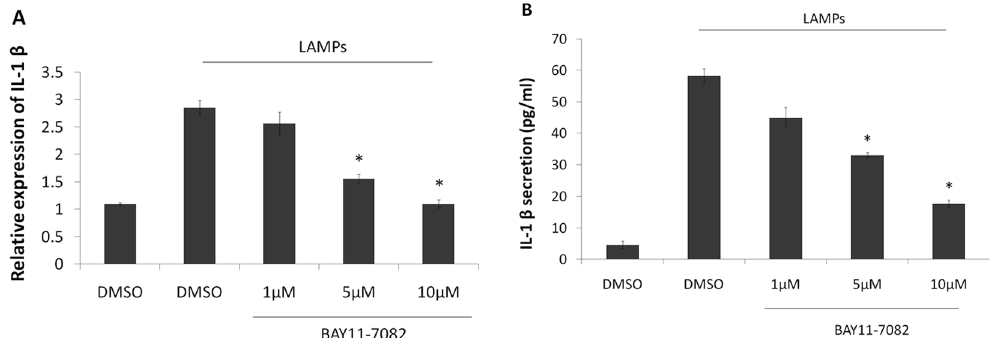
Figure 3. The NF- κ B signaling pathway regulates Mmm-derived LAMP-induced IL-1 β expression in EBL cells. EBL cells were stimulated or not with 1 μ g/ml Mmm-derived LAMPs and then treated with an NF- κ B inhibitor (1,5, or 10 μ M) or DMSO in the absence of serum for 6 h. The cells and supernatants were respectively harvested and analyzed by real-time PCR and ELISA. Data are presented as the mean and standard deviation of three assays. * p < 0.05 compared with LAMP-stimulated cells.